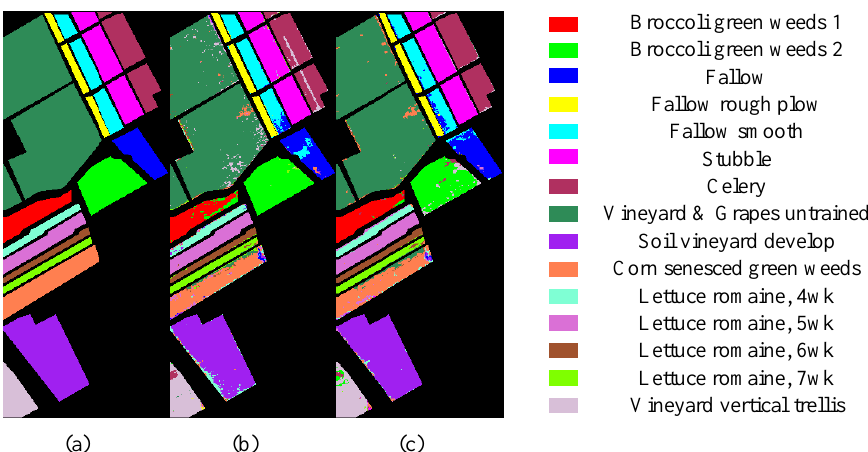
Figure 3. RGB composition maps resulting from classification for the Salinas scene dataset. From left to right: (a) ground truth, (b) a traditional deep CNNs, and (c) the proposed